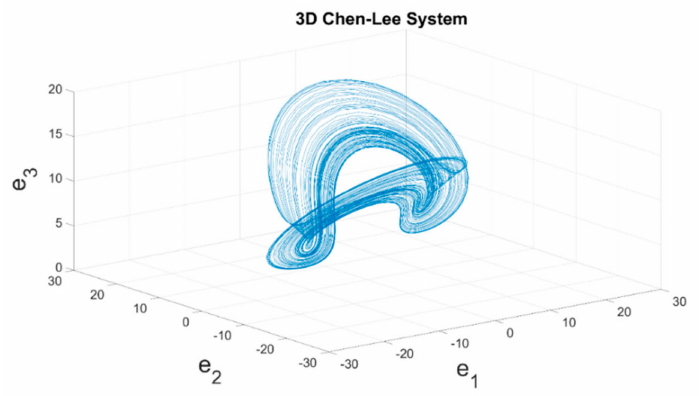
Figure 4. 3D phase portraits of the Chen–Lee